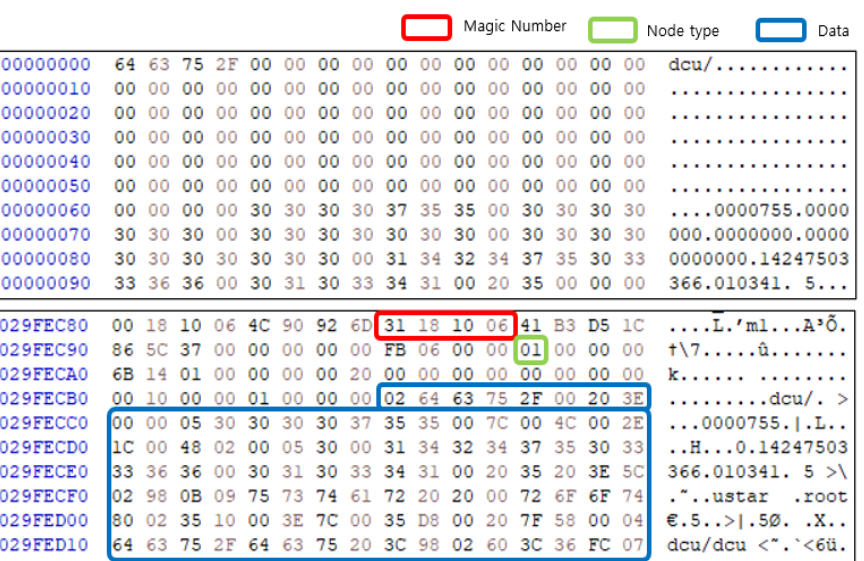
Figure 21. UBIFS directory of entry ( top )/data node ( bottom ).